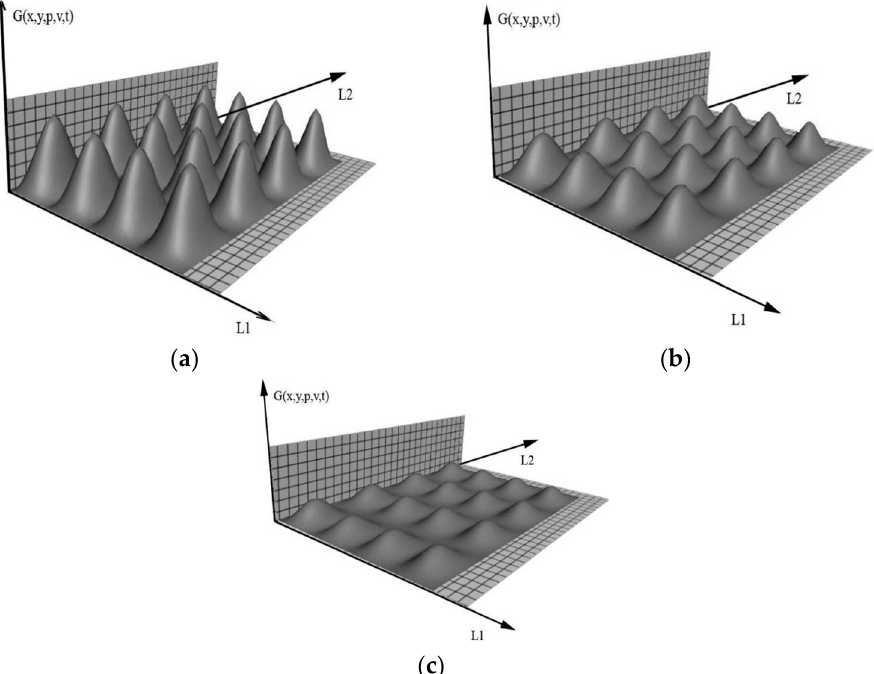
Figure 5. Dynamic change of the temperature field depending on time. ( a ) before change; ( b ) cycle change; ( c ) after change